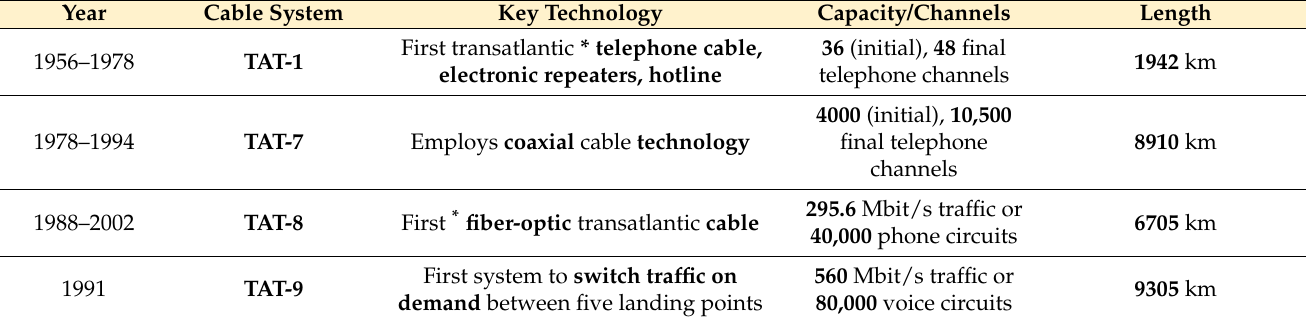
Table 1. Important milestones in submarine networks history